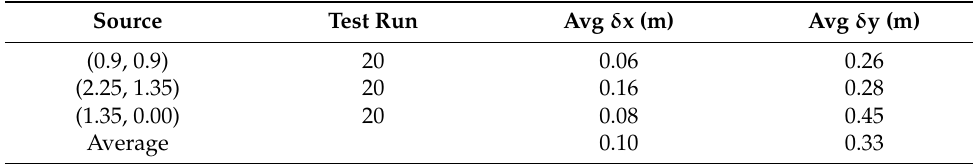
Table 1. 2D localization results with a triangular array.